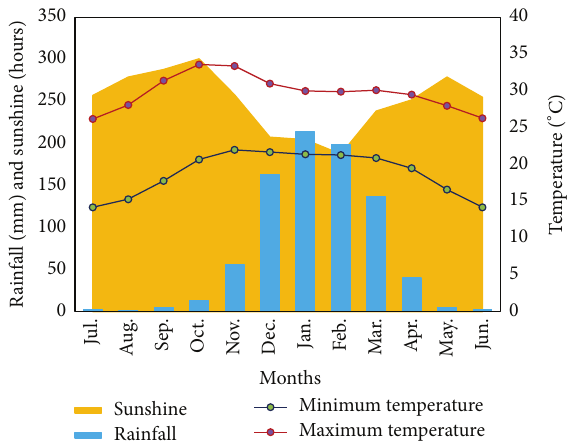
Figure 1: Weather from July 2013 to June 2014 for the study